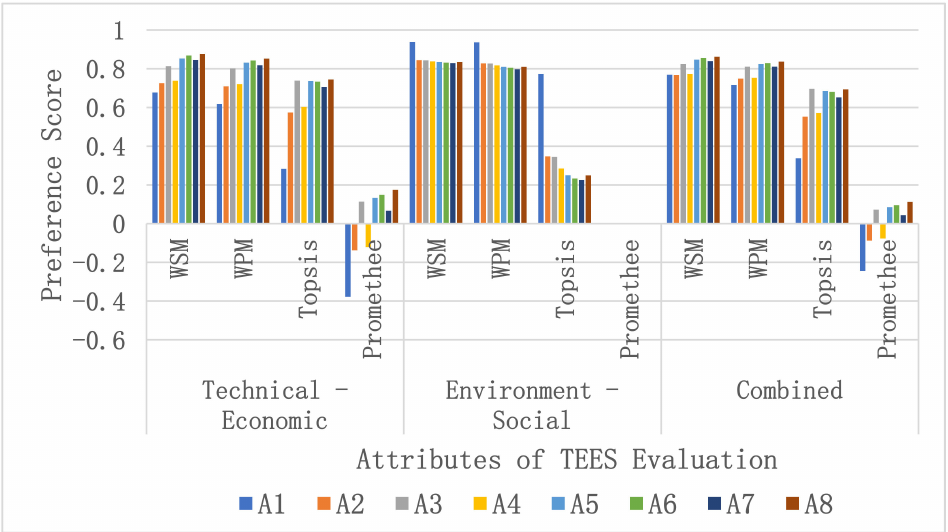
Figure 9. Attributes of TEES evaluation for C1/S2 with DGs only at 0.9 PF under